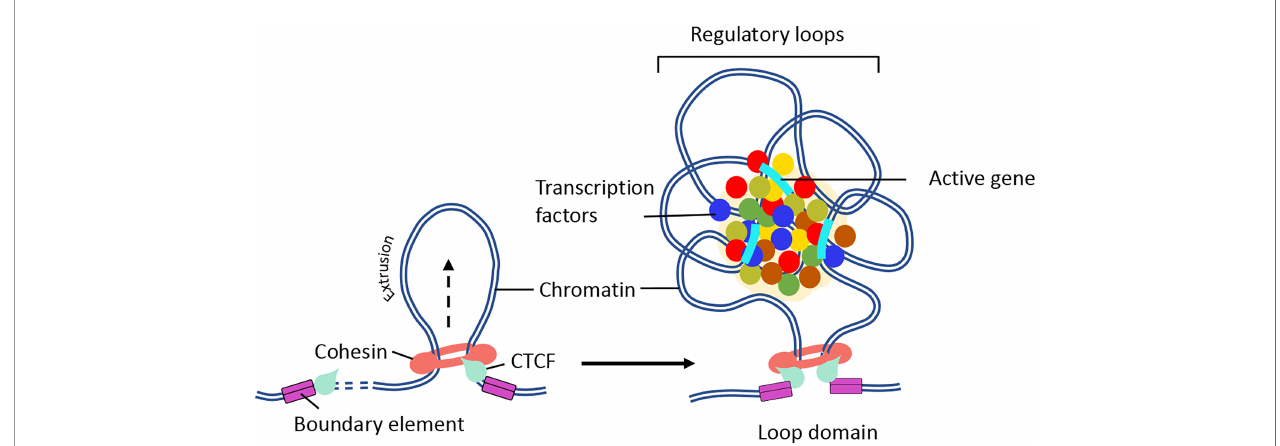
FIGURE 3 | Mechanism of chromatin loop formation. TADs contain varying number of chromatin loops generated through loop extrusion by CTCF/cohesin complexes. Chromatin loop formation facilitates interactions between promoter and enhancer elements. (Right panel) In the presence of NIPBL and MAU2, the cohesin complex loaded on to the DNA. Then, cohesin extrudes chromatin until a pair of convergent CTCF binding sites is reached. (Right panel) The N-terminus of CTCF and convergent positioning of the CTCF-DNA complex stabilizes cohesin binding and stall chromatin extrusion leading to the establishment higher-order chromatin organization. The intervening DNA between two convergent CTCF sites leads to the formation of a loop domain, which adopts variety of complex shapes comprised of multiple regulatory loops. The internal structure of loop domain is likely determined by polymer chromatin-chromatin self-interactions, which may be further stabilized by phase separation. The contacts within the loop domains facilitate the targeting of enhancers to speci fi c genes (104). The black arrow depicts the direction of loop